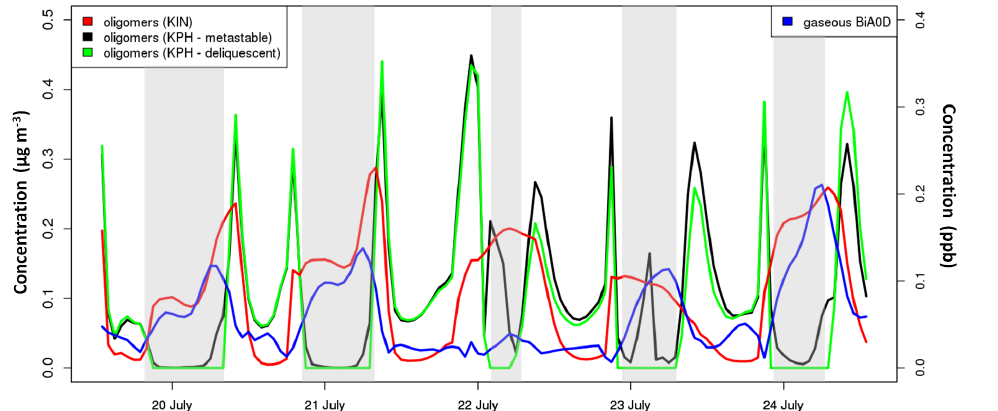
Figure 7. Time series of BiA0D concentrations (ppb) in the reference simulation (blue line), the KIN (red line) oligomer concentrations (µgm − 3 ), and the KPH oligomer concentrations (µgm − 3 ) in the deliquescent mode (green line) and in the metastable mode (black line), as simulated with CHIMERE for the 20–24 July 2006 period in northern Spain. The shaded areas correspond to the presence of a dry aerosol in the deliquescent